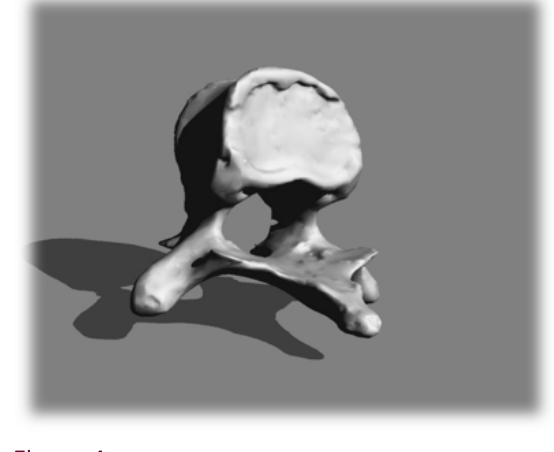
Scan of a human vertebra rendered in a JPEG format as a prototype for the campus grant